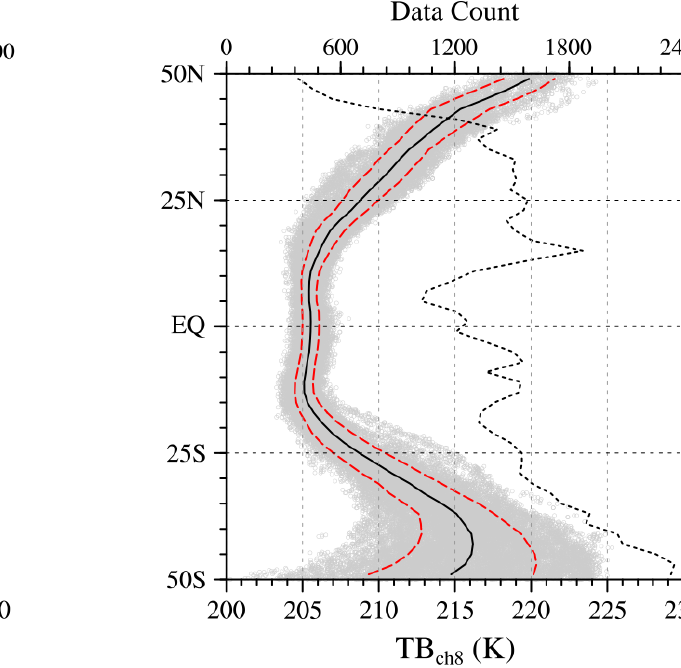
Figure 5. Data counts within each 0.5 K × 0.5 K box to show the correlations between ( a , b ) bright-